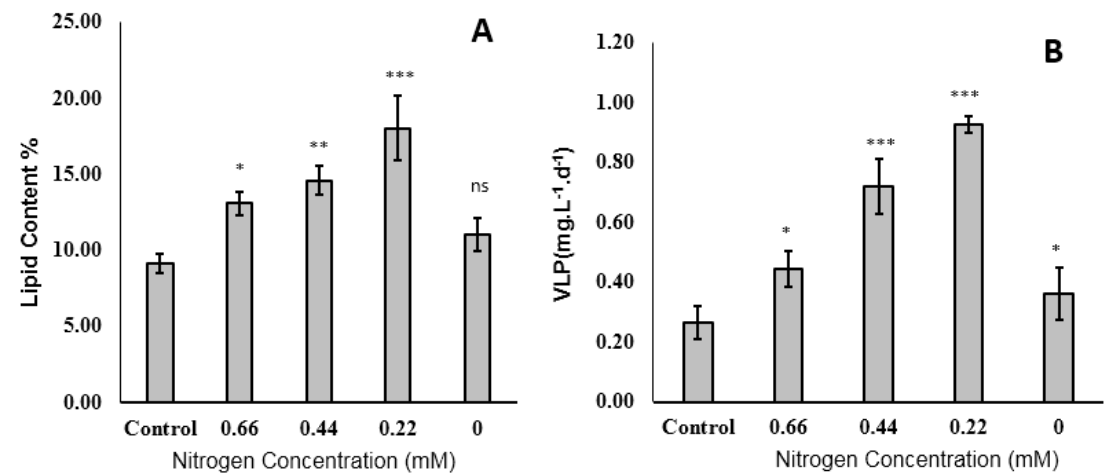
Figure 5. Lipid content ( A ) and volumetric lipid productivity (VLP) ( B ) of Tisochrysis lutea grown mixotrophically in different concentrations of NaNO 3. * p < 0.05, ** p < 0.01, *** p < 0.001, ns: not significant with respect to the control (0.88 mM).